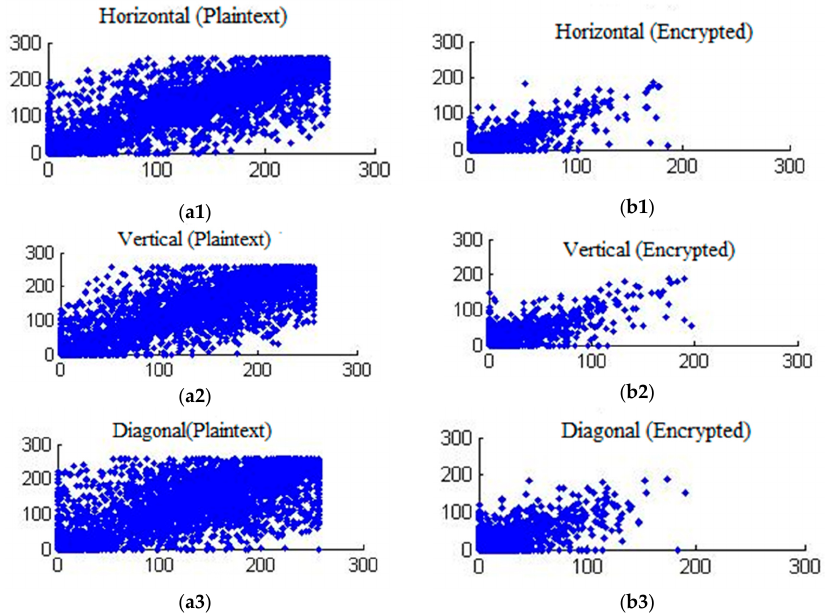
Figure 7. Comparative Pixel correlation of mobile video sequence for plaintext in ( a1 ) horizontal direction, ( a2 ) vertical direction ( a3 ) diagonal direction and when encrypted with EXPer in ( b1 ) horizontal direction, ( b2 ) vertical direction ( b3 ) diagonal direction.